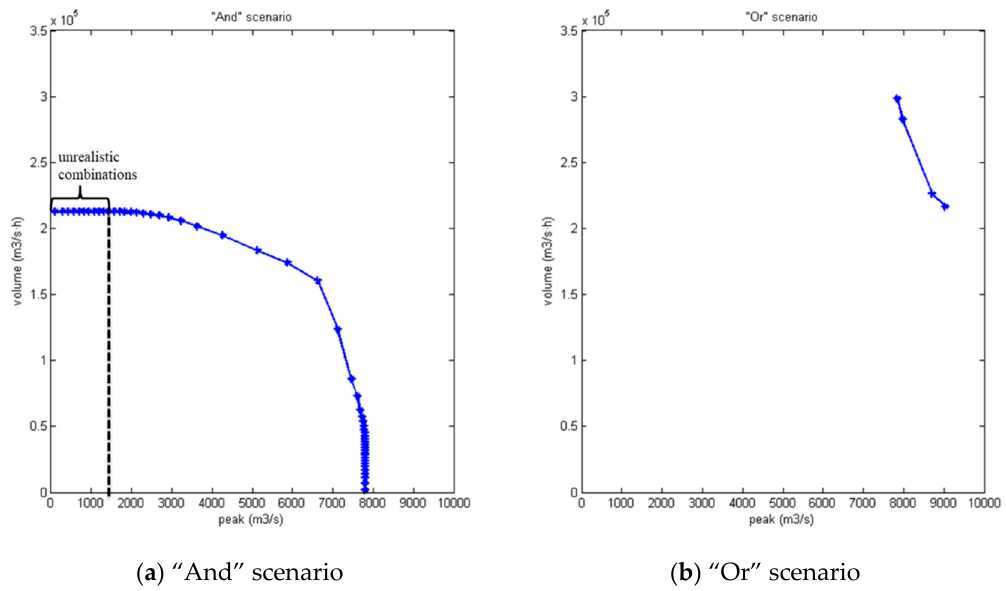
Figure 10. Peak–volume combinations on the 0.01 frequency contour line.